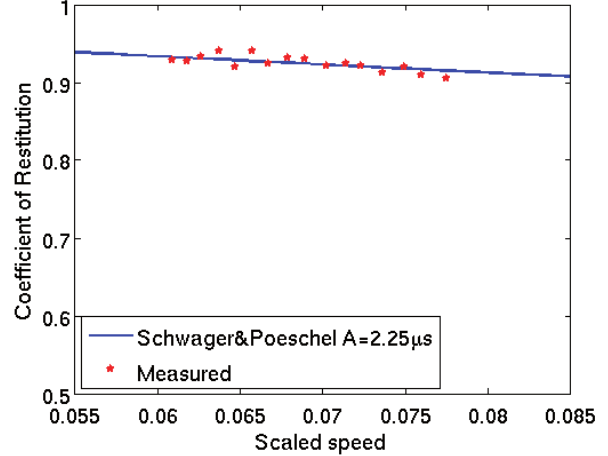
Fig. 6. Coefficient of restitution as a function of nondimensional speed: Theory and